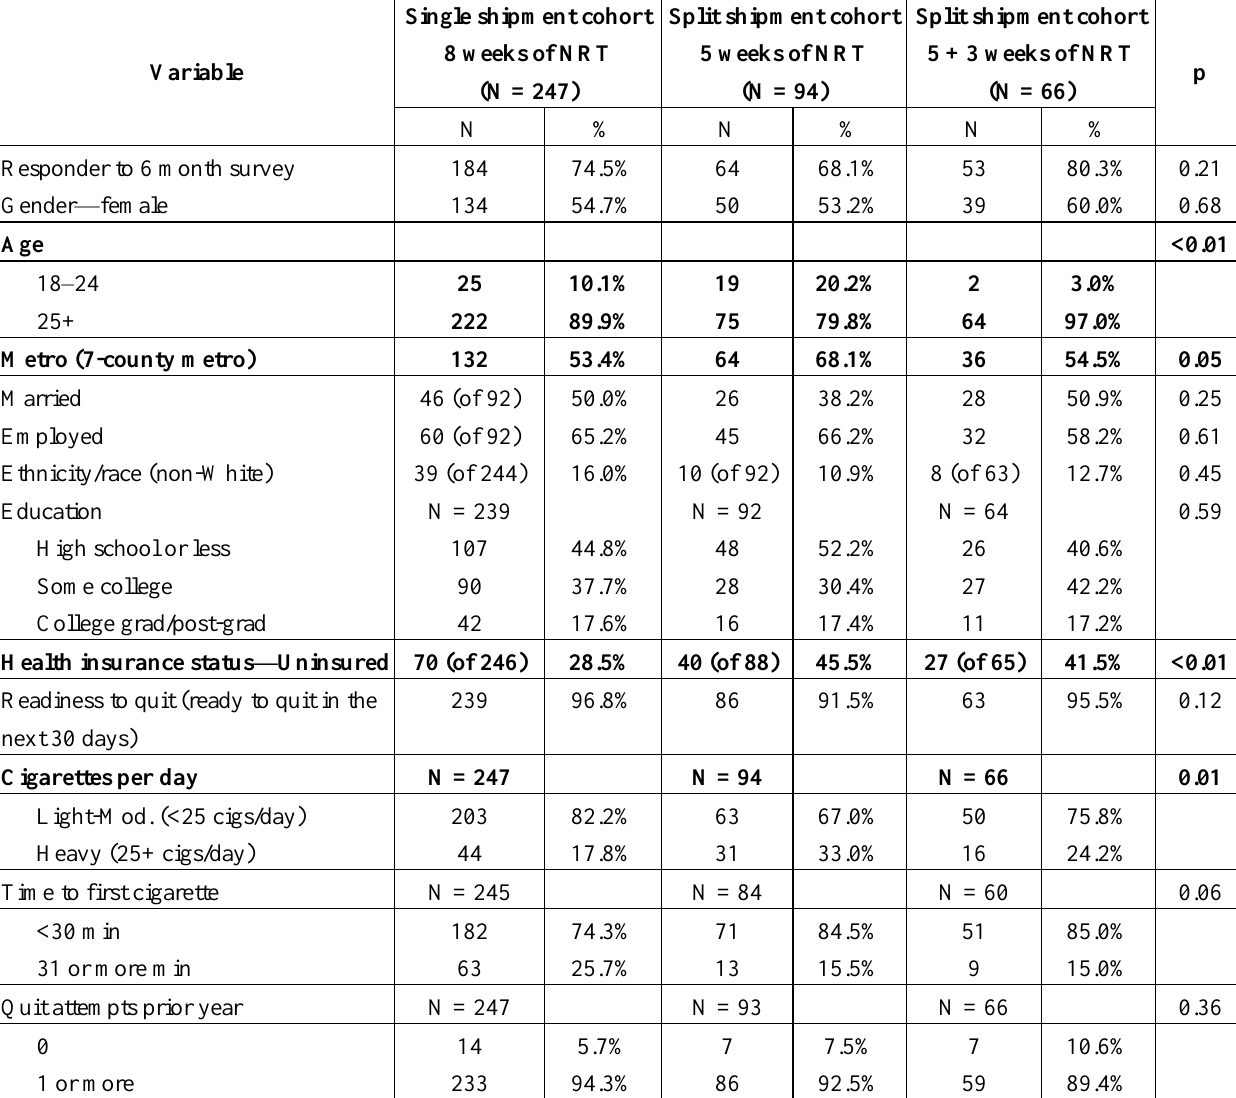
Table 2. Baseline characteristics of callers by NRT protocol